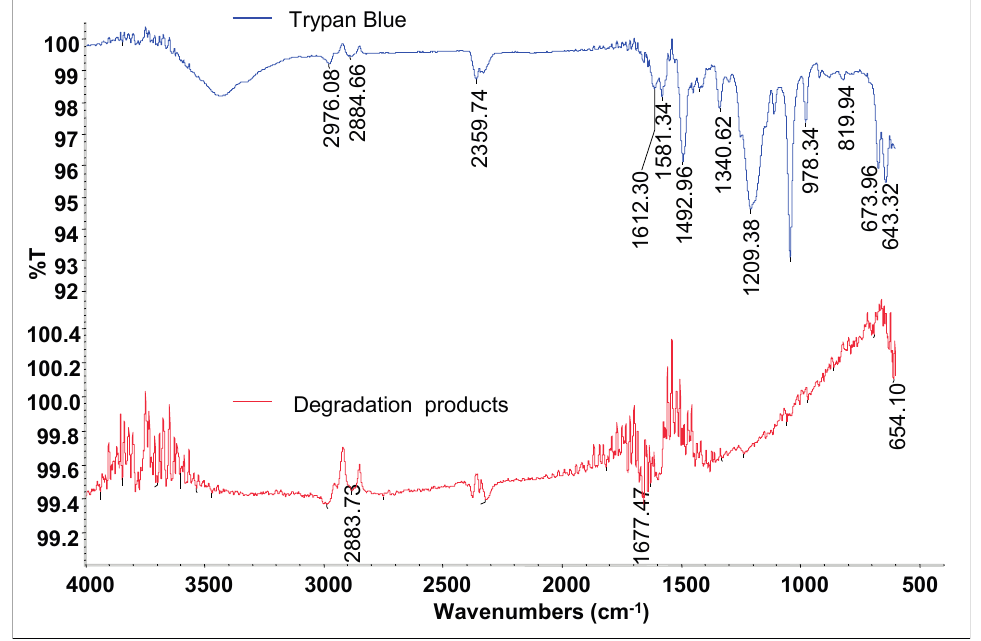
Figure 6. HPLC elution profile of ( a ) control dye Trypan Blue and ( b ) its degradation product at 210 nm.